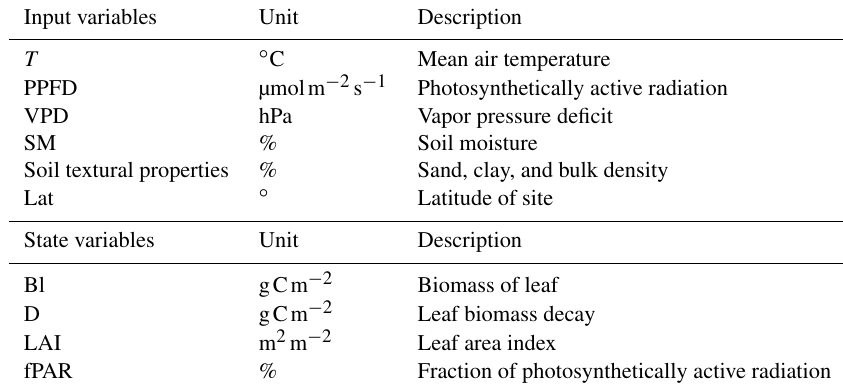
Table 2. List of input and state variables (at daily time step) in